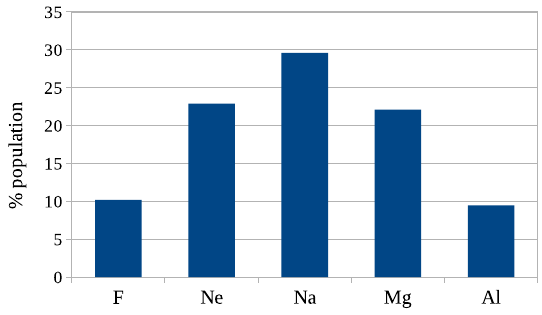
Figure 2. Estimated charge-state distribution of 56 Fe ions in the TDRIV measurement at ALTO.